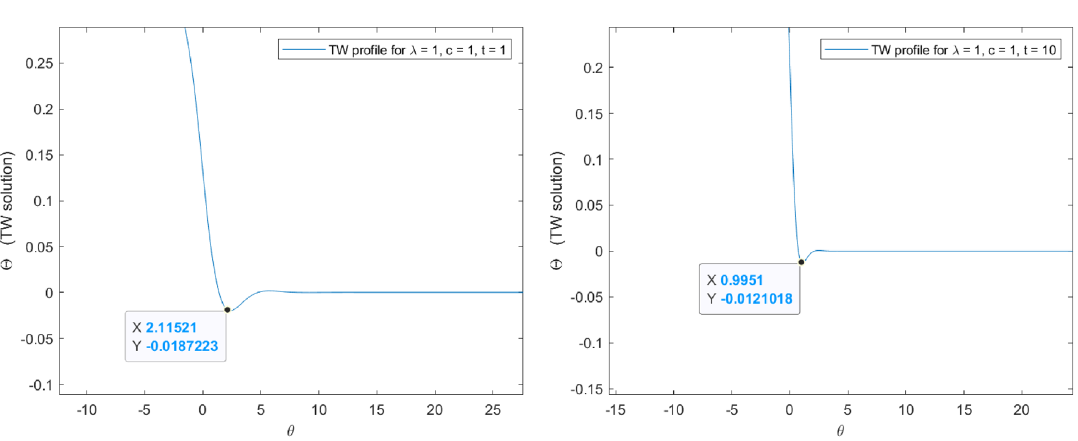
Figure 8. Exact travelling wave profiles for A = B = 1 . Note that the first minimum is negative and the profiles evolves